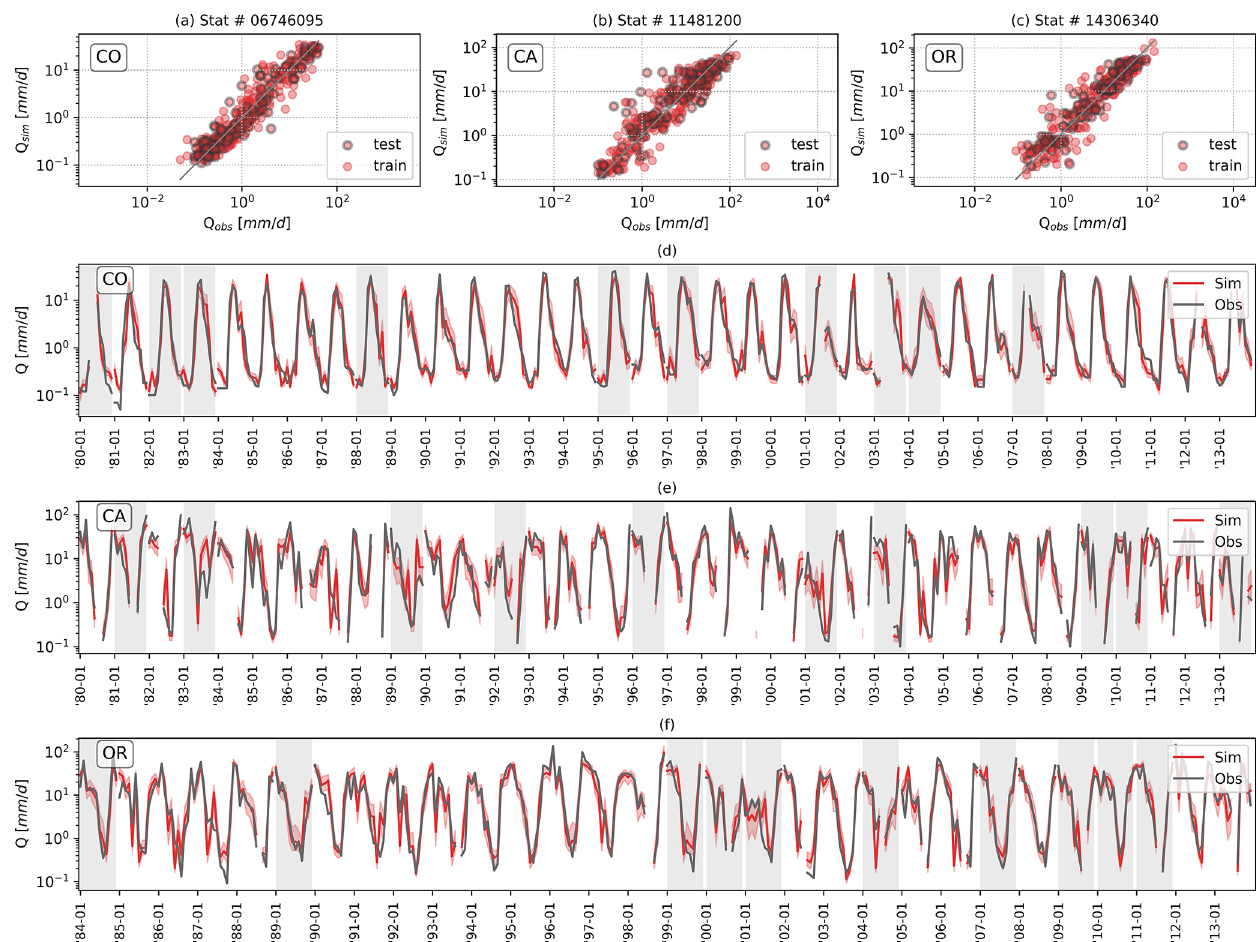
Figure 7. Comparison between maximum daily river discharge simulations from run 1 and observations of three different catchments. The grey shaded areas indicate years belonging to the test set. The shaded red areas represent the simulation confidence interval evaluated as the 5th and the 95th